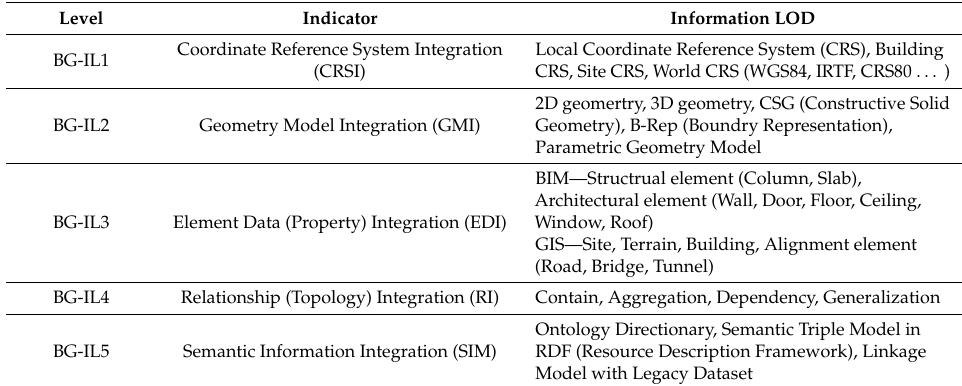
Table 9. BG-IL definition.